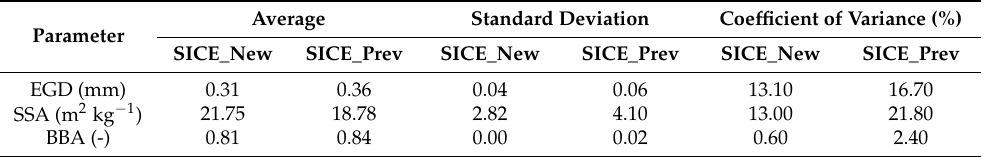
Figure 7. Retrieved spatial distributions ( A , C , E ) and histogram ( B , D , F ) of the retrieved EGD ( A , B ), SSA ( C , D ), and BBA ( E , F ) in the range 81–82S, 120–130E (31 January 2020, 22:26UTC) using OLCI/S- 3B observations over eastern Antarctica. The visible features the northwestern corner of panels ( A , C , E ) are the artifact due to the presence Dome C station. Table 7. Average, standard deviation and coefficient of variance of the retrieved parameters with the updated SICE algorithm (SICE_New) and with the previous version of the algorithm (SICE_Prev) presented in [8] for the area presented in Figure